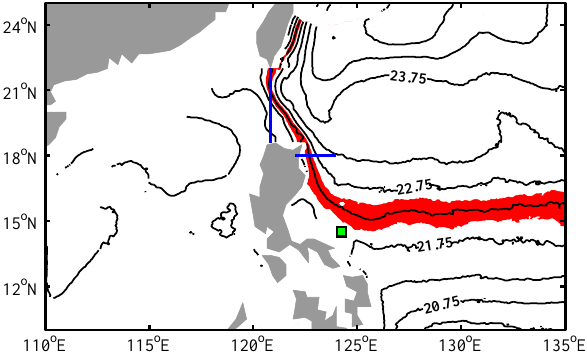
Figure 6. Same as Fig. 5 except for the annual average (con- tours). The red stripe represents the pathway of the North Equato- rial Current–Kuroshio circulation system. The green box indicates the location of the mean NEC bifurcation. The two blue lines indi- cate the transects for computing Kuroshio transport (KT) and Luzon Strait transport (LST), respectively.